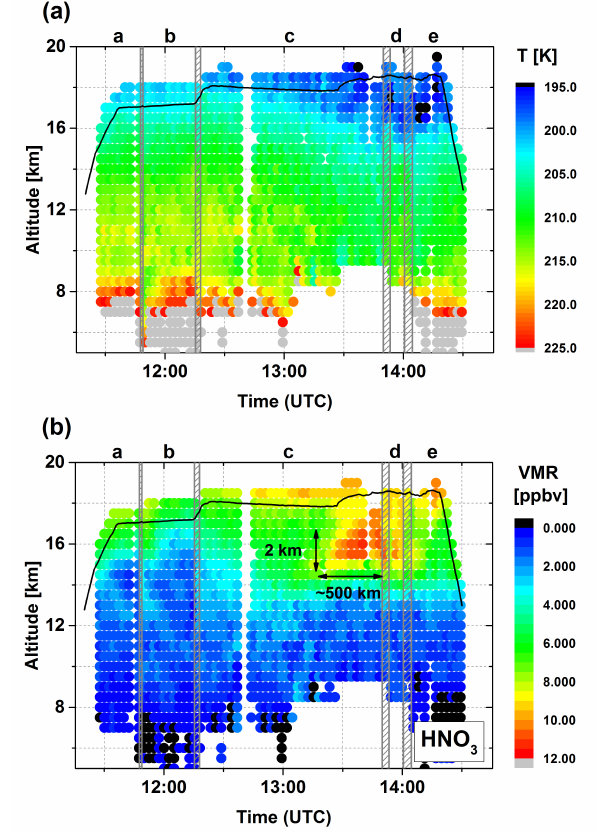
Figure 6. Vertical cross sections of temperature ( T ) and HNO 3 ( g ) along the flight track retrieved from the MIPAS-STR observations. Vertical flight profile (black line) and turns between different flight legs (grey hatched areas). Data points are filtered for a vertical res- olution better than